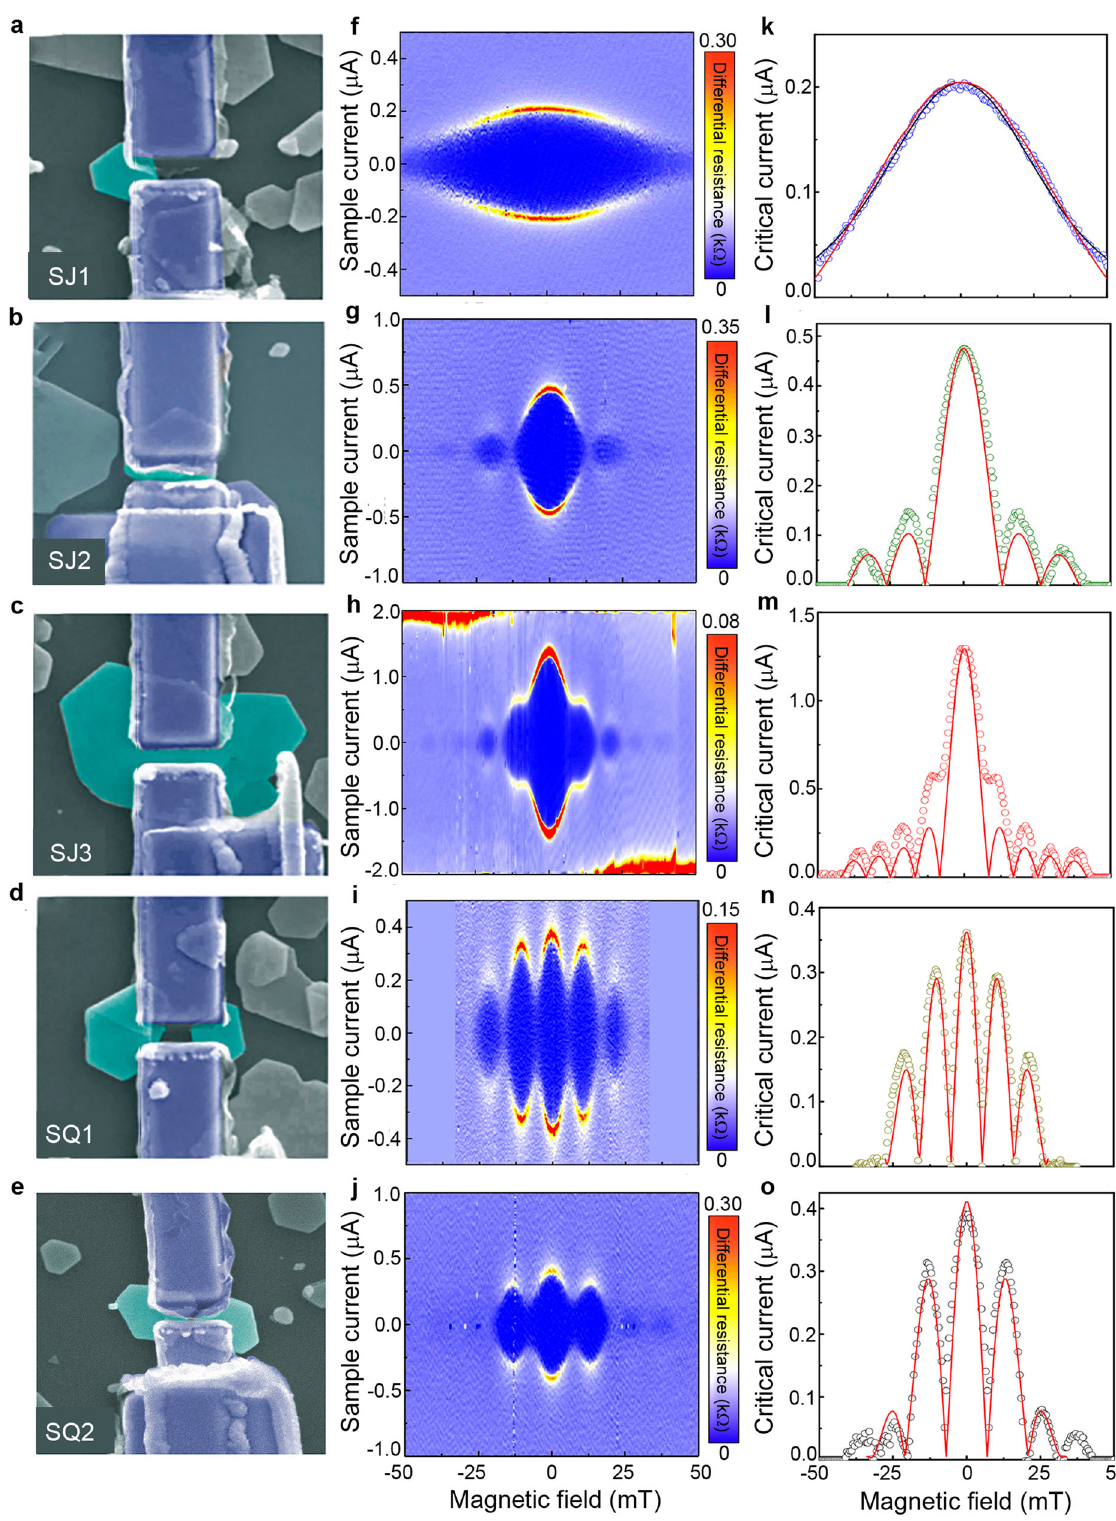
shape/size of Bi 2 Te 2.3 Se 0.7 nanocrystals and on how they are connected to Nb leads. In Fig. 2f – j we present 2D plots of the color-coded differential resistance d V /d I of each junction as a function of the bias current and the external magnetic fi eld; I c ( H ) variations are plotted in Fig. 2k – o, respectively. These curves clearly remind Fraunhofer-like I c ( H ) interference